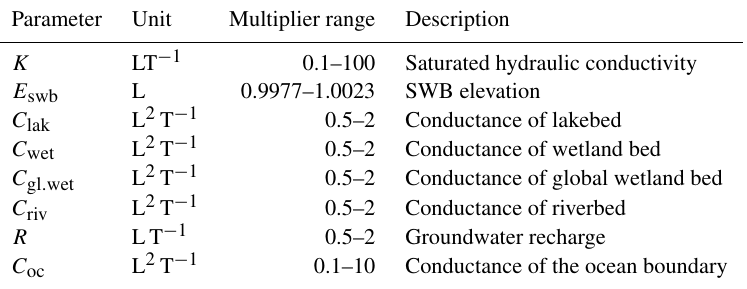
Table 1. Range of parameter multipliers used in the Morris experiments. Each parameter multiplier is sampled in log space (log 10 (Multiplier)) with sampling based on Campolongo et al. (2007) and optimized with Ruano et al. (2012).